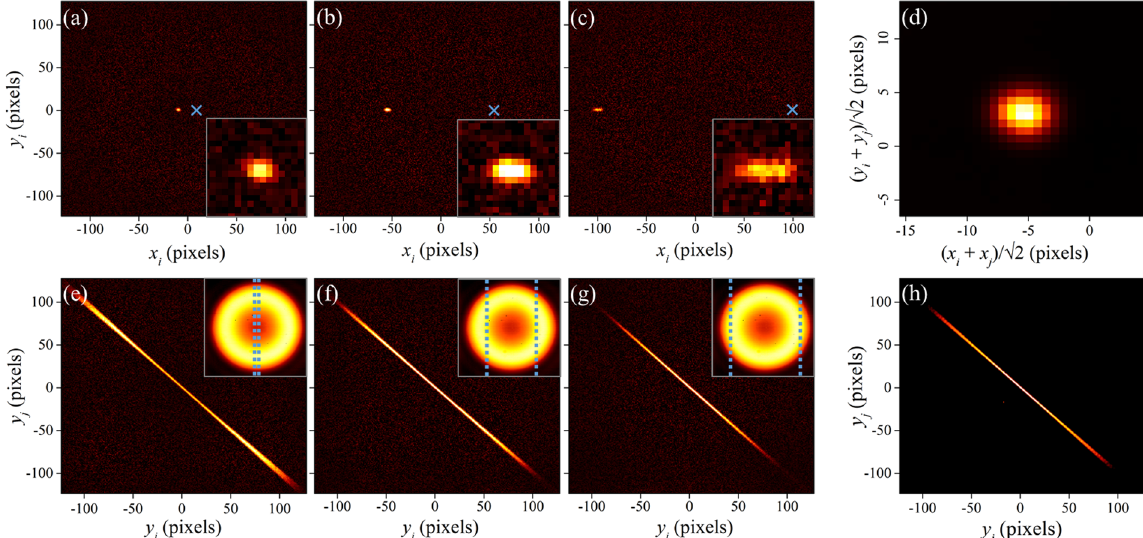
Figure 2. Information contained in the full 4D measurement of biphoton joint probability distribution. ( a – c ) at different distances from the center, indicated by blue × , showing anti-correlation of width Variation of Γ i j that increases with | x | (see insets). ( d ) Projection of Γ onto sum coordinates averages the variations in ( a – c ). ( e – ij for fixed x x [ , ] (indicated by blue dashed lines in inset of 〈 C ) showing variation in anti- g ) 2D slices of Γ i 〉 ij i j onto y y [ , ] (integration over x and x ) averages the correlation with horizontal separation. ( h ) Projection of Γ i ij j i j structures in ( e – g ), giving only a mean